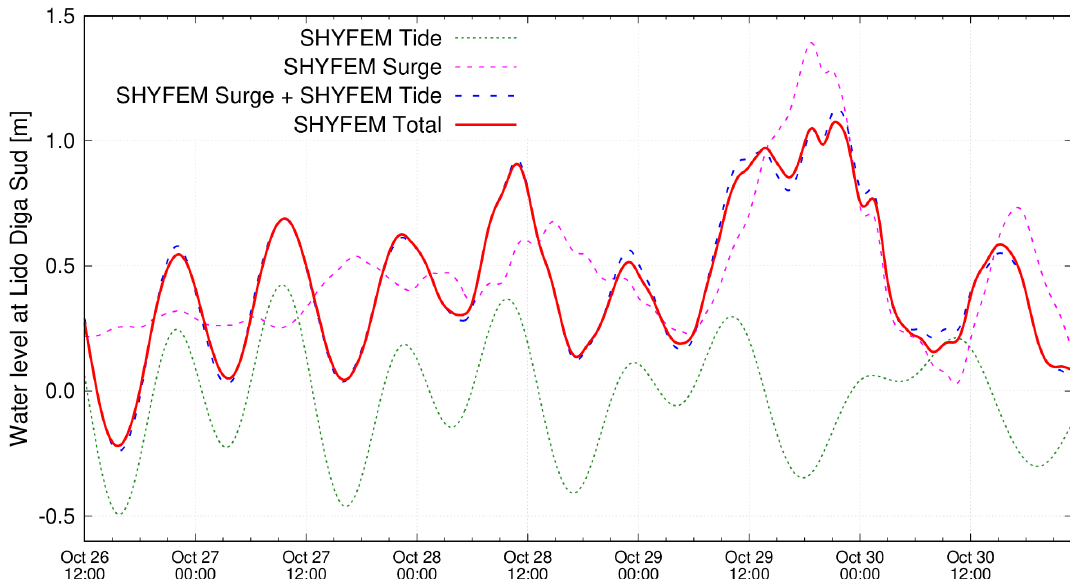
Figure B1. Simulation of the event A9 described in Appendix A performed with SHYFEM (Shallow water HYdrodynamic Finite El- ement Model; see Cavaleri et al., 2019, for details). The different curves represent the model results using only the astronomical tidal forcing (SHYFEM Tide), the meteorological forcing (SHYFEM Surge), and the full forcing (SHYFEM Total). The dashed line (SHYFEM Surge + SHYFEM Tide) is the algebraic sum of the SHYFEM Tide and SHYFEM Surge